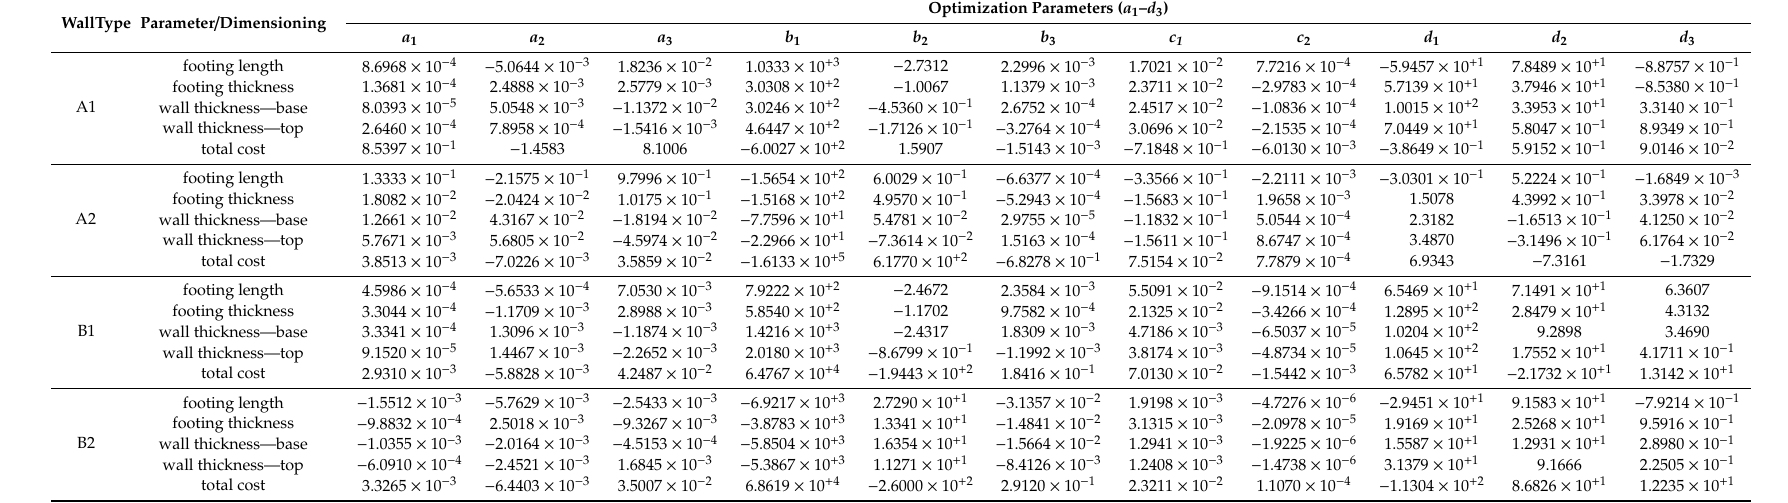
Table A1. Optimization parameters a 1 – d